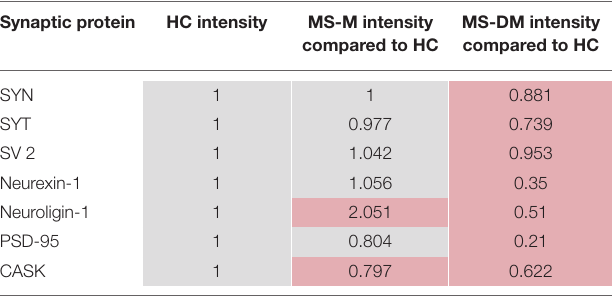
TABLE 3 | The intensity of different proteins measured in the hippocampus by Dutta et al. (11). Synaptic